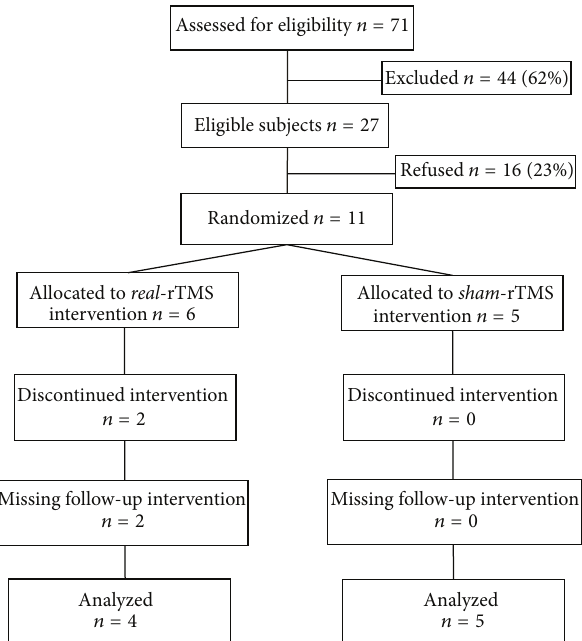
Figure 1: Flow of subjects through the trial according to the CONSORT statement (rTMS, repetitive Transcranial Magnetic Stimulation).